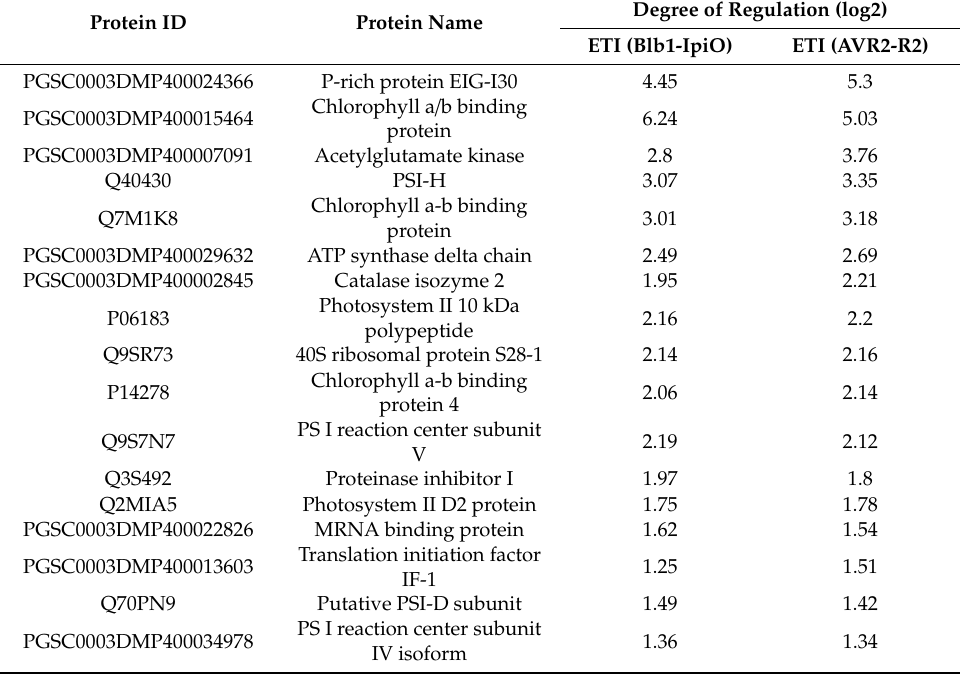
Table 3. Proteins from two ETI interactions with increased abundance (ETI-IpiO and ETI-Avr2), 18 hpi (hours post infiltration). A comparison was made between the immune-treated plants and the control plants infiltrated with medium only. All values are in log2 fold. Non-significant p values are indicated by NA. All p -values < 0.01 are shown in the